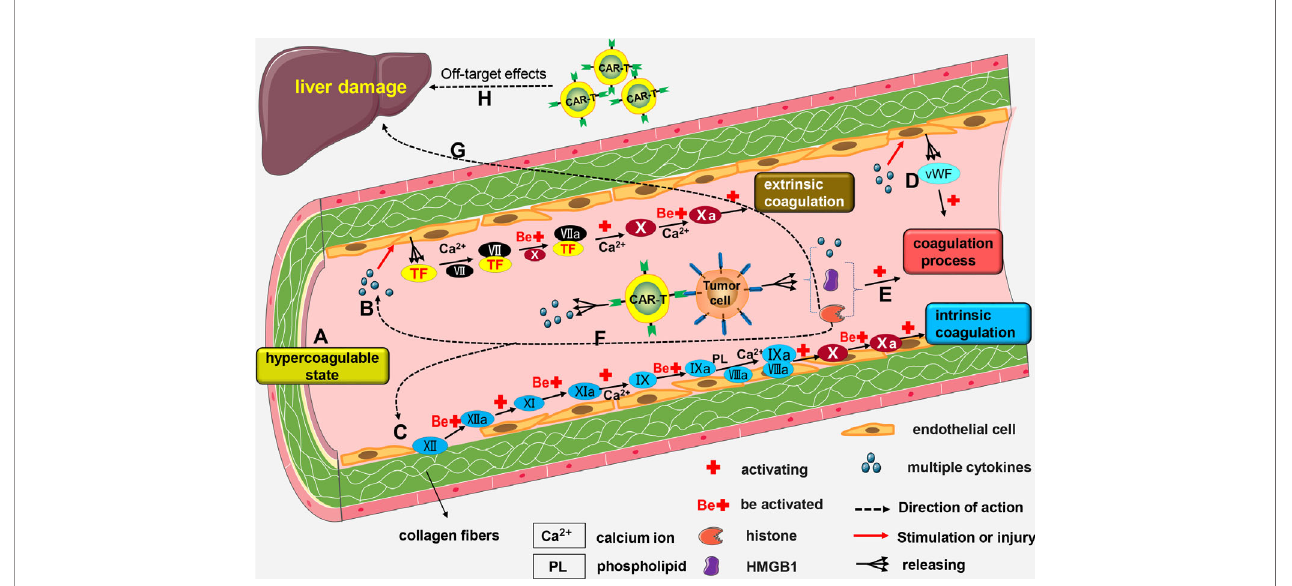
FIGURE 3 | The mechanism of CAR-T-related coagulation dysfunction. (A) Blood from patients with malignant tumors is in a hypercoagulable state; (B) High number of cytokines can trigger the formation of lesions by vascular endothelial cells, thereby promoting the release of TF. Calcium (Ca2+) facilitates the combination of FVII with TF to form the FVII/TF complex. Activated FX enhances the activation of FVII/TF complex to form FVIIa/TF complex. Calcium (Ca2+) mediates the activation of FX by VIIa/TF complex to form FXa. This results in the activation of the extrinsic coagulation pathway. (C) Damage to endothelial cells exposes the underlying collagen fi bers. Next, FXII combines with the exposed collagen fi bers to form FXIIa. FXI is activated by FXIIa and transformed into FXIa. FIX is then activated by FXIa and transformed into FIXa; a process driven by Ca2+. FIXa and FVIIIa combine to form a IXa/VIIIa complex under the regulation of Ca2+ and PL. The IXa/VIIIa complex complex activates FX and transforms it into FXa leading to the activation of intrinsic coagulation pathway. (D) Activated endothelial cells release vWF factor which contributes to blood coagulation. (E) Rupture of some malignant tumor cells results in the release of HMGB1 and histones, both of which cause coagulation dysfunction. (F) Histones can indirectly activate the intrinsic or extrinsic coagulation pathway. (G) Excessive production of histones into the blood stream may cause liver damage and impair the production of coagulation factors. (H) Severe damage to the liver cells cause by the off-target effects of CAR-T cells may also impair the production of coagulation